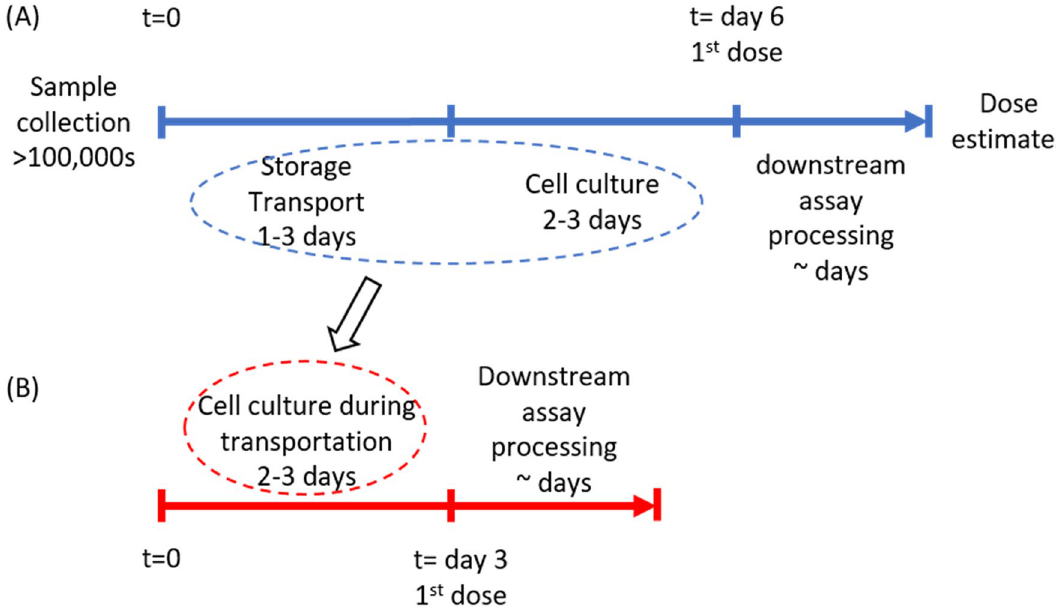
Figure 1. ( A ) Existing cytogenetic biodosimetry logistics: the response time to get the 1st dose result can be as long as 6 days due to shipping and cell culture; ( B ) our novel cytogenetic biodosimetry logistics: cell culture during transportation can dramatically decrease the response time of the biodosimetry to 3